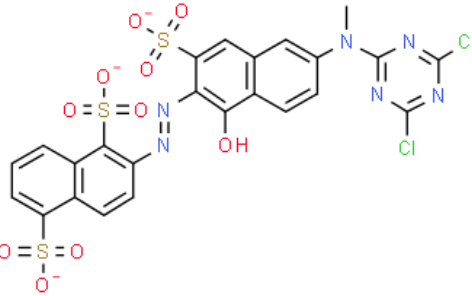
Figure 1. Chemical structure of C.I. Reactive Orange 4 [16].